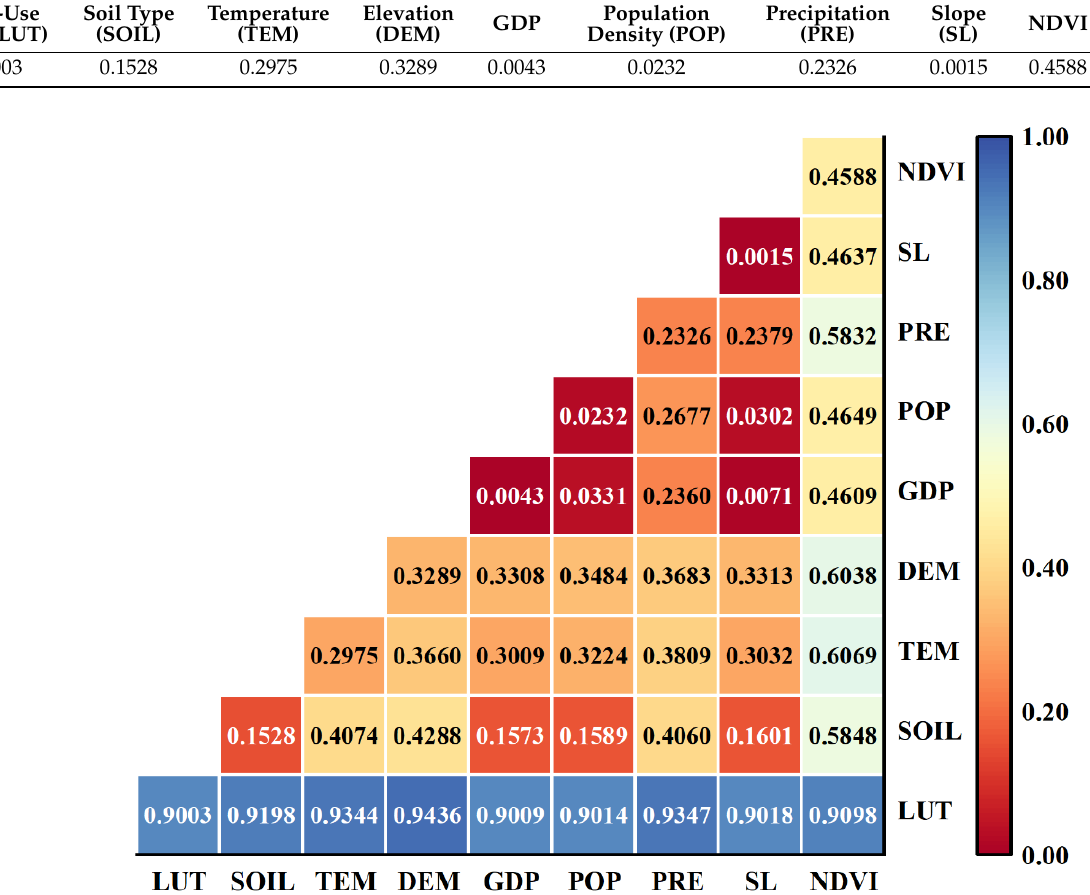
Figure 10. Interaction of influencing factors of spatial differentiation characteristics of habitat qual- ity. Table 8. Complex drivers of habitat quality change.